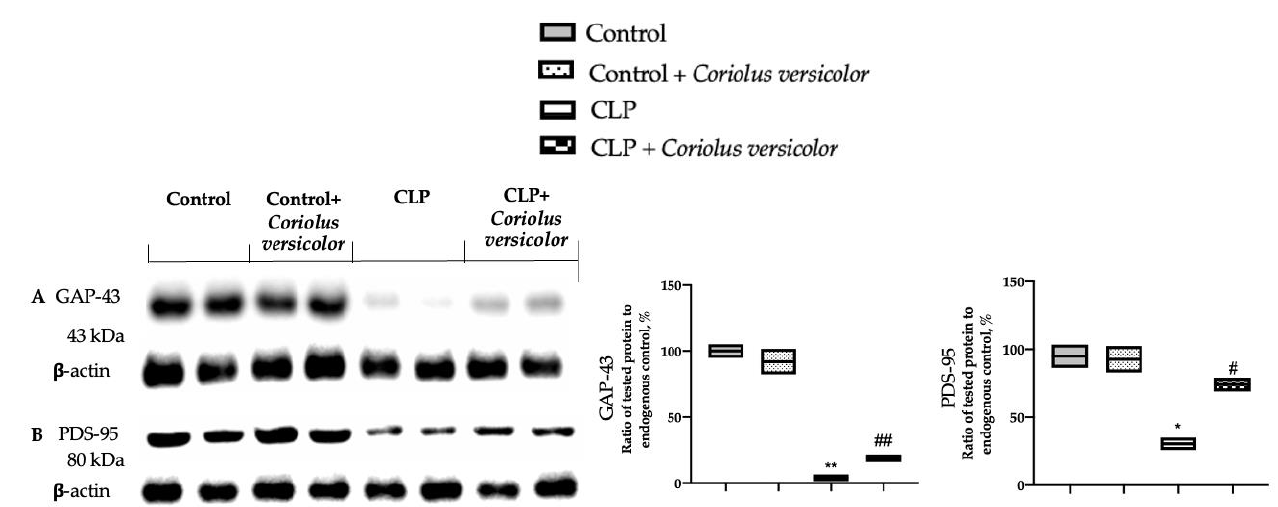
Figure 16. Coriolus versicolor restored synaptic injury in hippocampus induced by CLP 28 days after surgery. Western blot analysis of growth-associated protein-43 (GAP-43) ( A ) and postsynaptic density protein 95 (PSD-95) ( B ) expression. A p -value of less than 0.05 was considered significant. * p < 0.05 vs. control, # p < 0.05 vs. CLP, ## p < 0.01 vs. CLP, ** p < 0.01 vs.